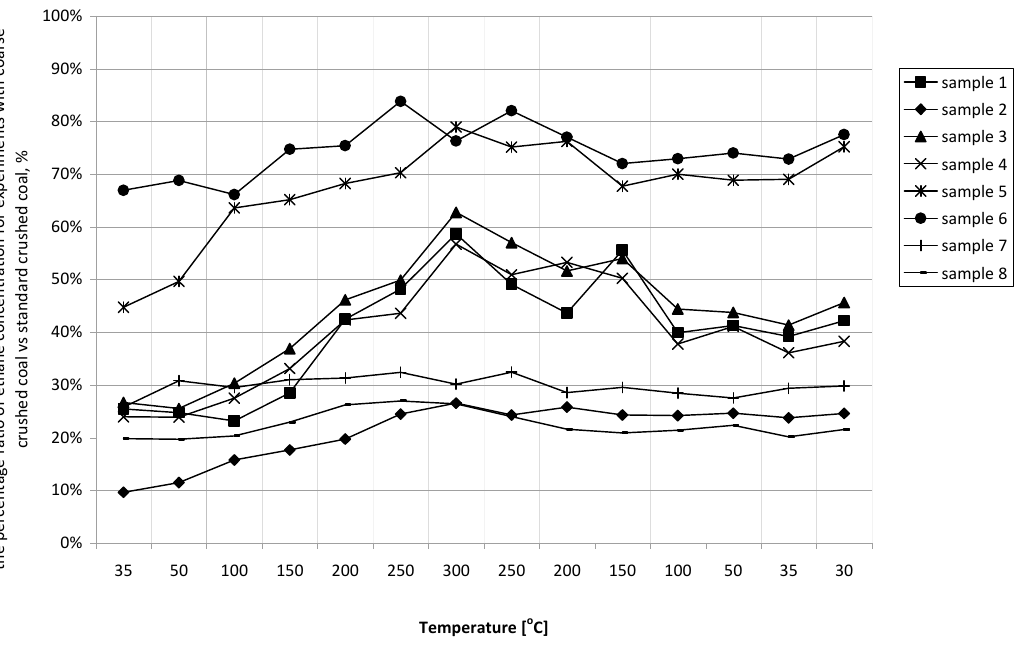
Figure 3. The course of changes in the ratio of released ethane (coarse vs. standard coal crushing) in the stage of heating and cooling of coal samples.